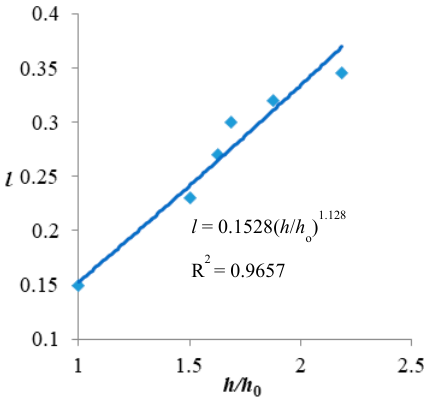
Figure 2. The relationship between traffic flow loss rate l and rainstorm intensity h , h 0 = 16 mm/h.